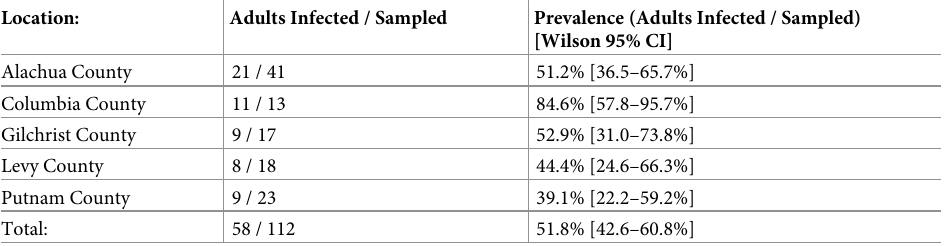
Table 1. Infection prevalence of Trypanosoma cruzi by county for adult Virginia opossums. A total of 112 Virginia opossums were sampled. Location: